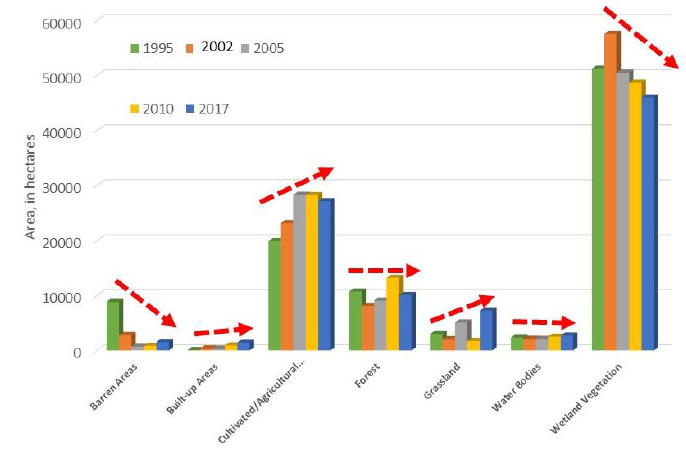
Figure 7. Overall trend of land-cover changes for the Agusan Marsh.